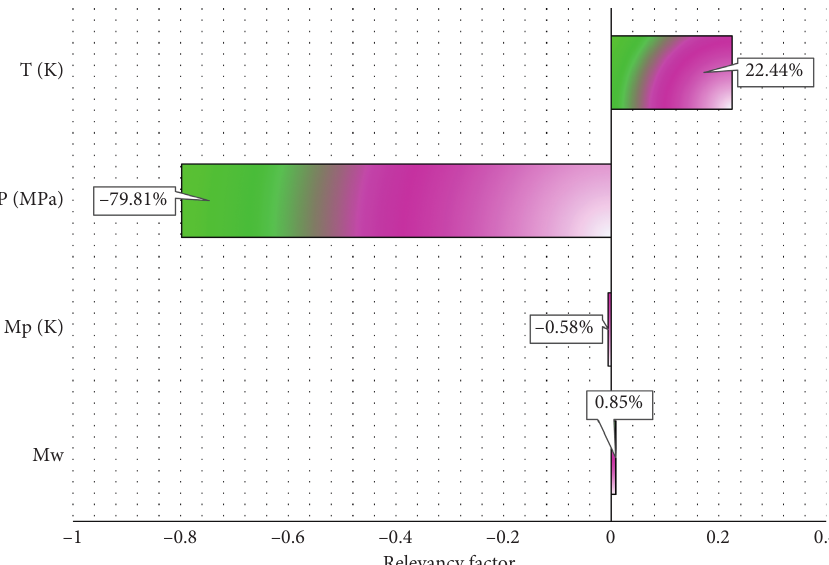
Figure 4: Sensitivity analysis for determining the impact of input parameters on the isothermal compressibility.